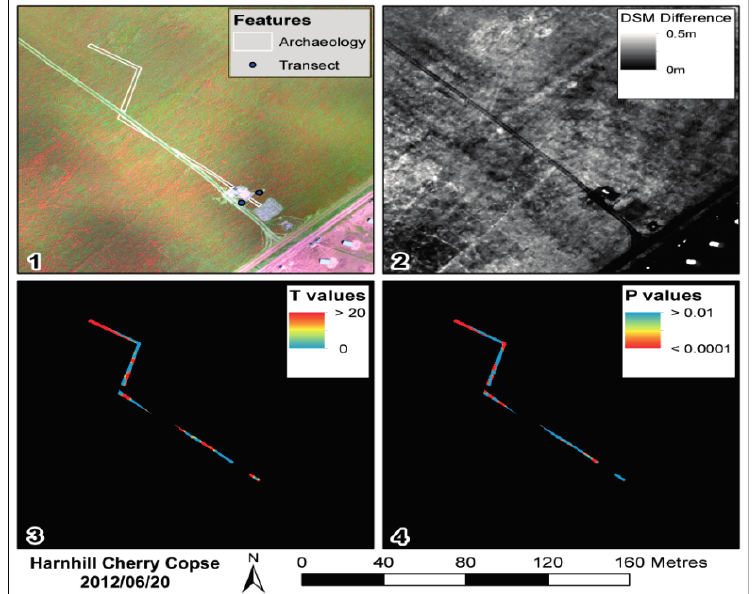
Figure 6. Multi-temporal airborne-LiDAR derived CHM for Harnhill Quarry Field for June 2012. (1) For comparison, aerial photography showing the locations of the archaeological features overlaid by those identified by magnetometer survey; (2) CHM data (referred to as difference in DSMs); (3) T -values indicating the strength of the localised contrast between the archaeological features and the background as exhibited by the CHM; (4) P -values indicating the localised statistical significance of the contrast.